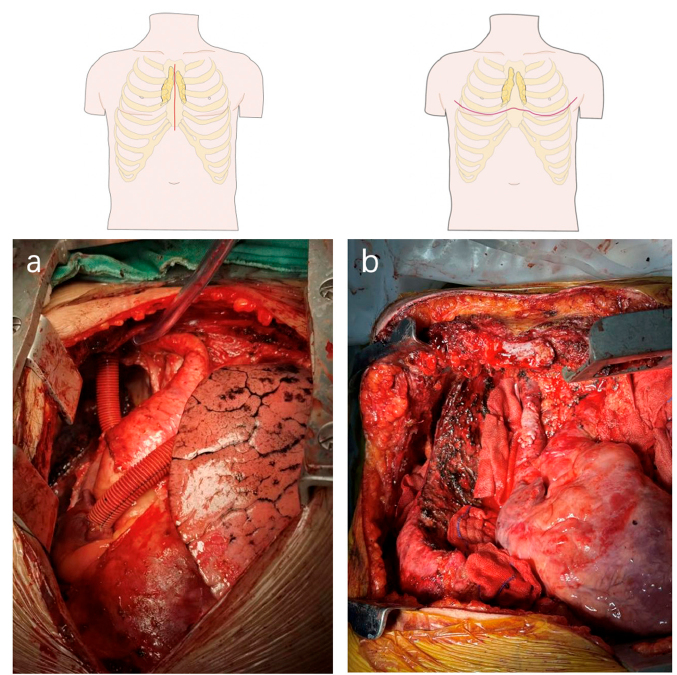
Figure 1. Picture of surgical approach. ( a ). Median sternotomy with a high vascular anastomosis ( b ). Clamshell incision.